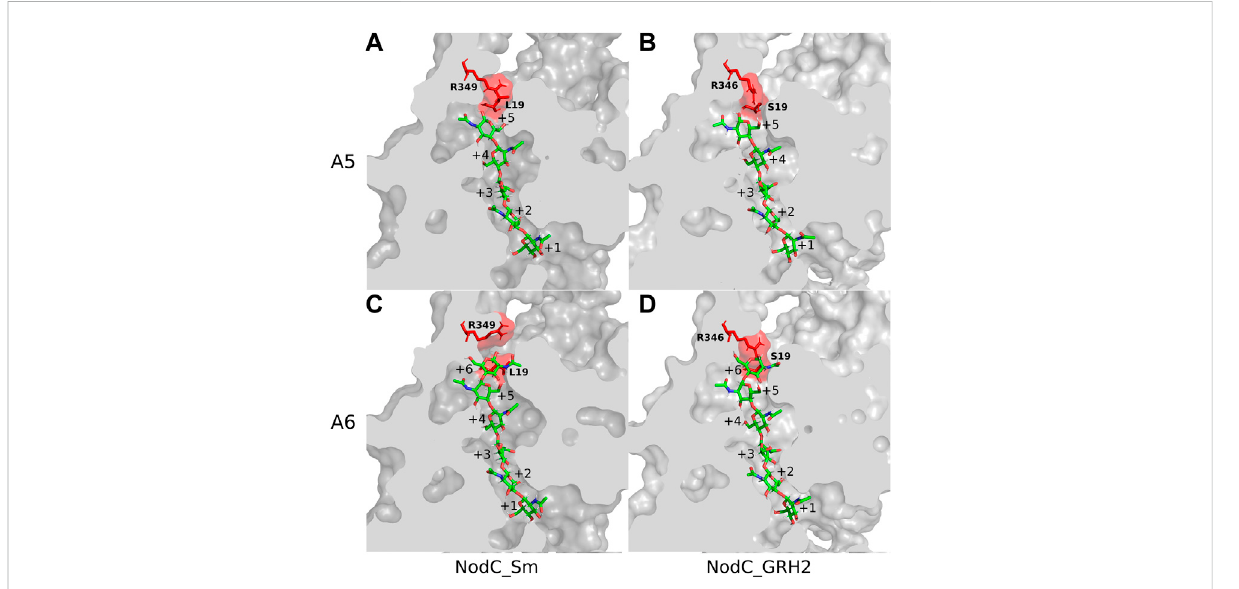
FIGURE 3 Chitin synthases NodC_GRH2 and NodC_Sm with pentamer/hexamer in their product binding sites. Depicted are the enzymes with the respective chitooligosaccharide (COS) after energy minimization. The two amino acids potentially limiting COS length are highlighted in red: R349 and L19 for NodC_Sm (A,C) and R346 and S19 for NodC_GRH2 (B,D) . Both NodC_Sm (A) and NodC_GRH2 (B) naturally produce chitin pentamer, but NodC_Sm ’ s main product is the tetramer. To accommodate a hexamer, bulky amino acids such as the arginine must be rotated away from the COS for NodC_Sm (C) , while NodC_GRH2 has more space and a sixth binding site (D) . The COS are shown in a stick representation, with green carbon, red oxygen, and blue nitrogen